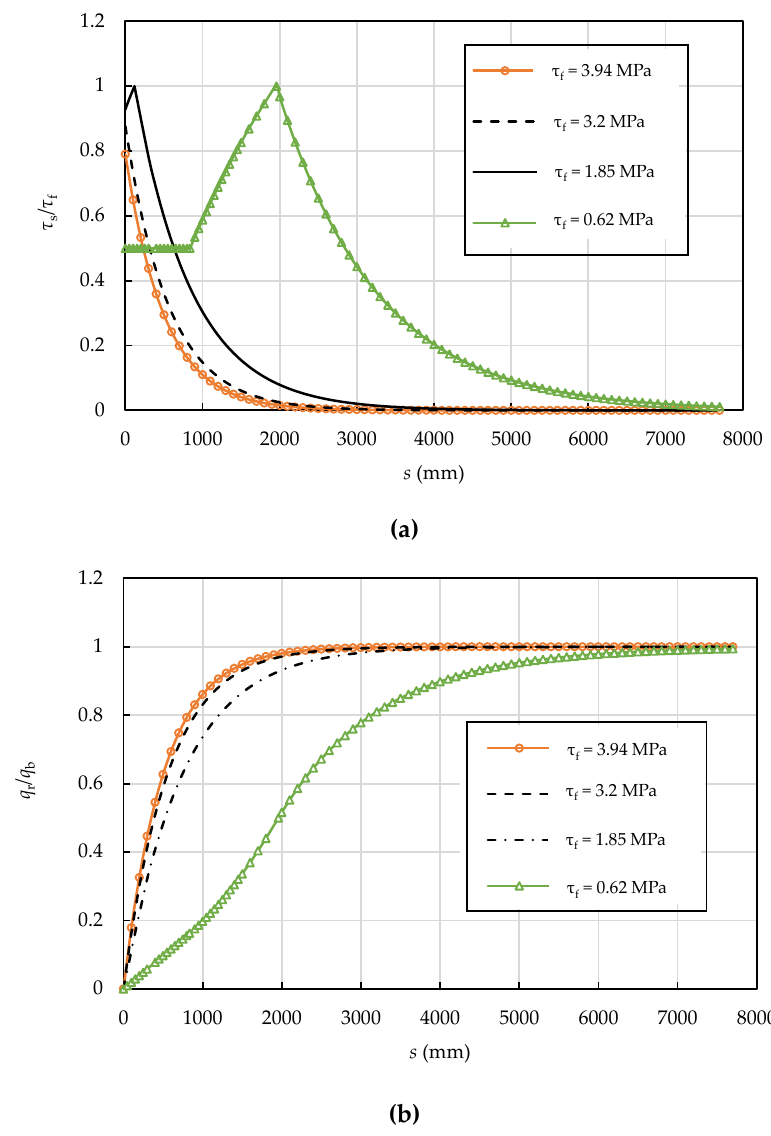
Figure 13. Effect of interfacial shear strength on the ( a ) interfacial shear and ( b ) normal stress distributions ( δ 1 = 3.0 mm, k = 0.5, and δ f = 6.6 mm).